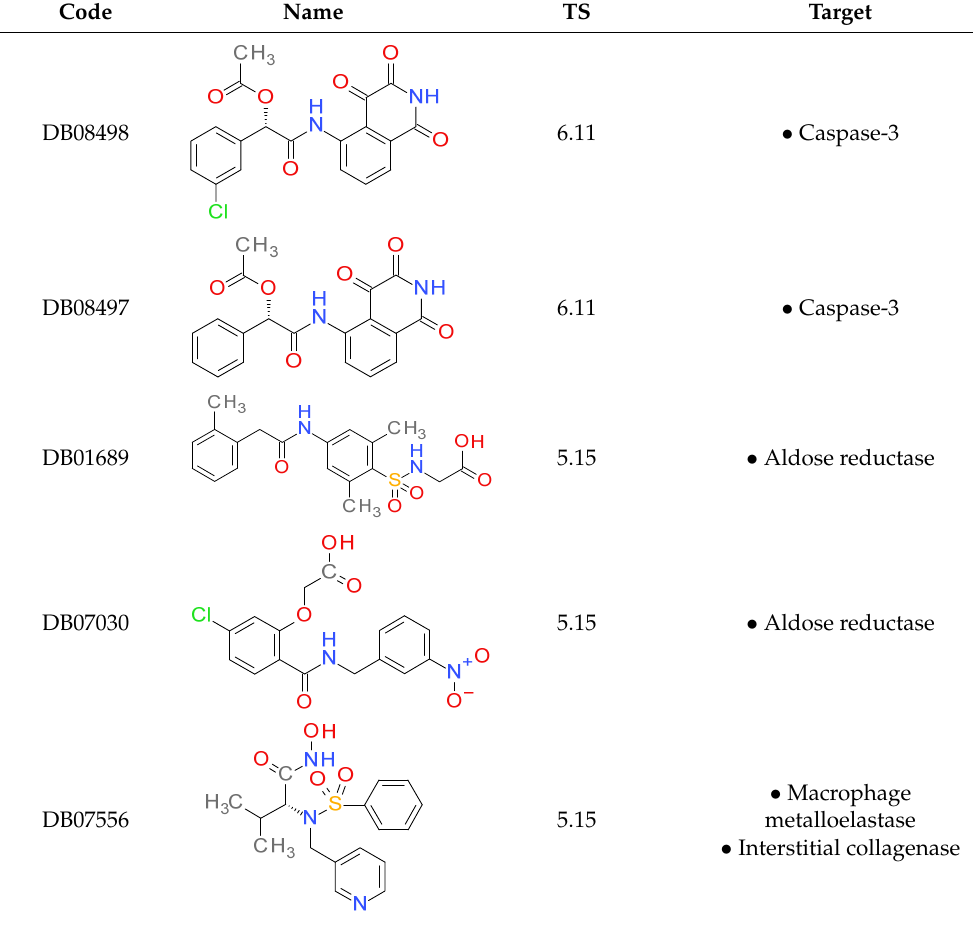
Table 5. The top DrugBank candidates based on their TS value and their known pharmacological targets.